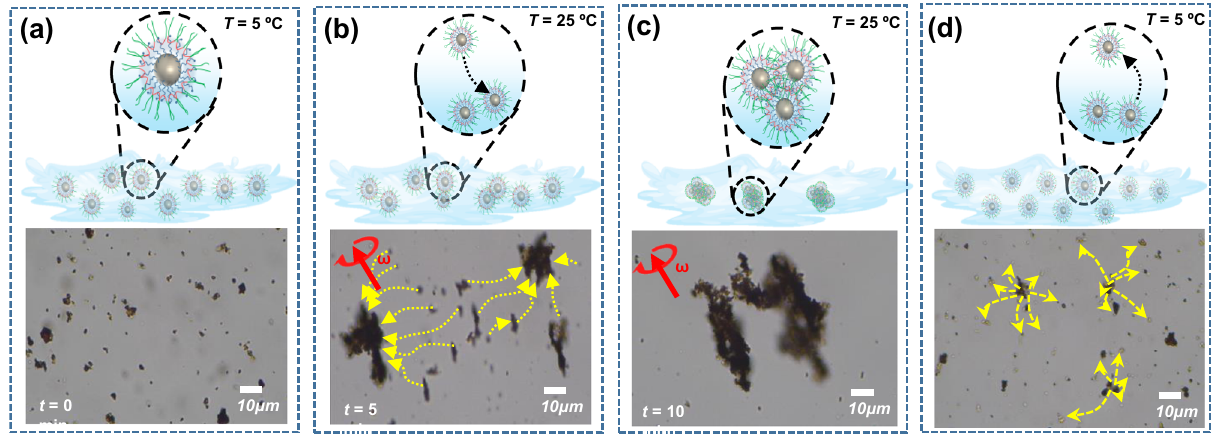
Fig. 4 Schematic representation of TM nanorobot motion during pickup and disposing of toxic pollutants under a transversal rotating magnetic fi eld. (a) scattered TM nanorobots, ( b ) begin accumulating of TM nanorobots with their toxic payloads, ( c ) aggregated TM nanorobots, and ( d ) dispersion of TM nanorobots and toxic pollutants ’ disposal at low